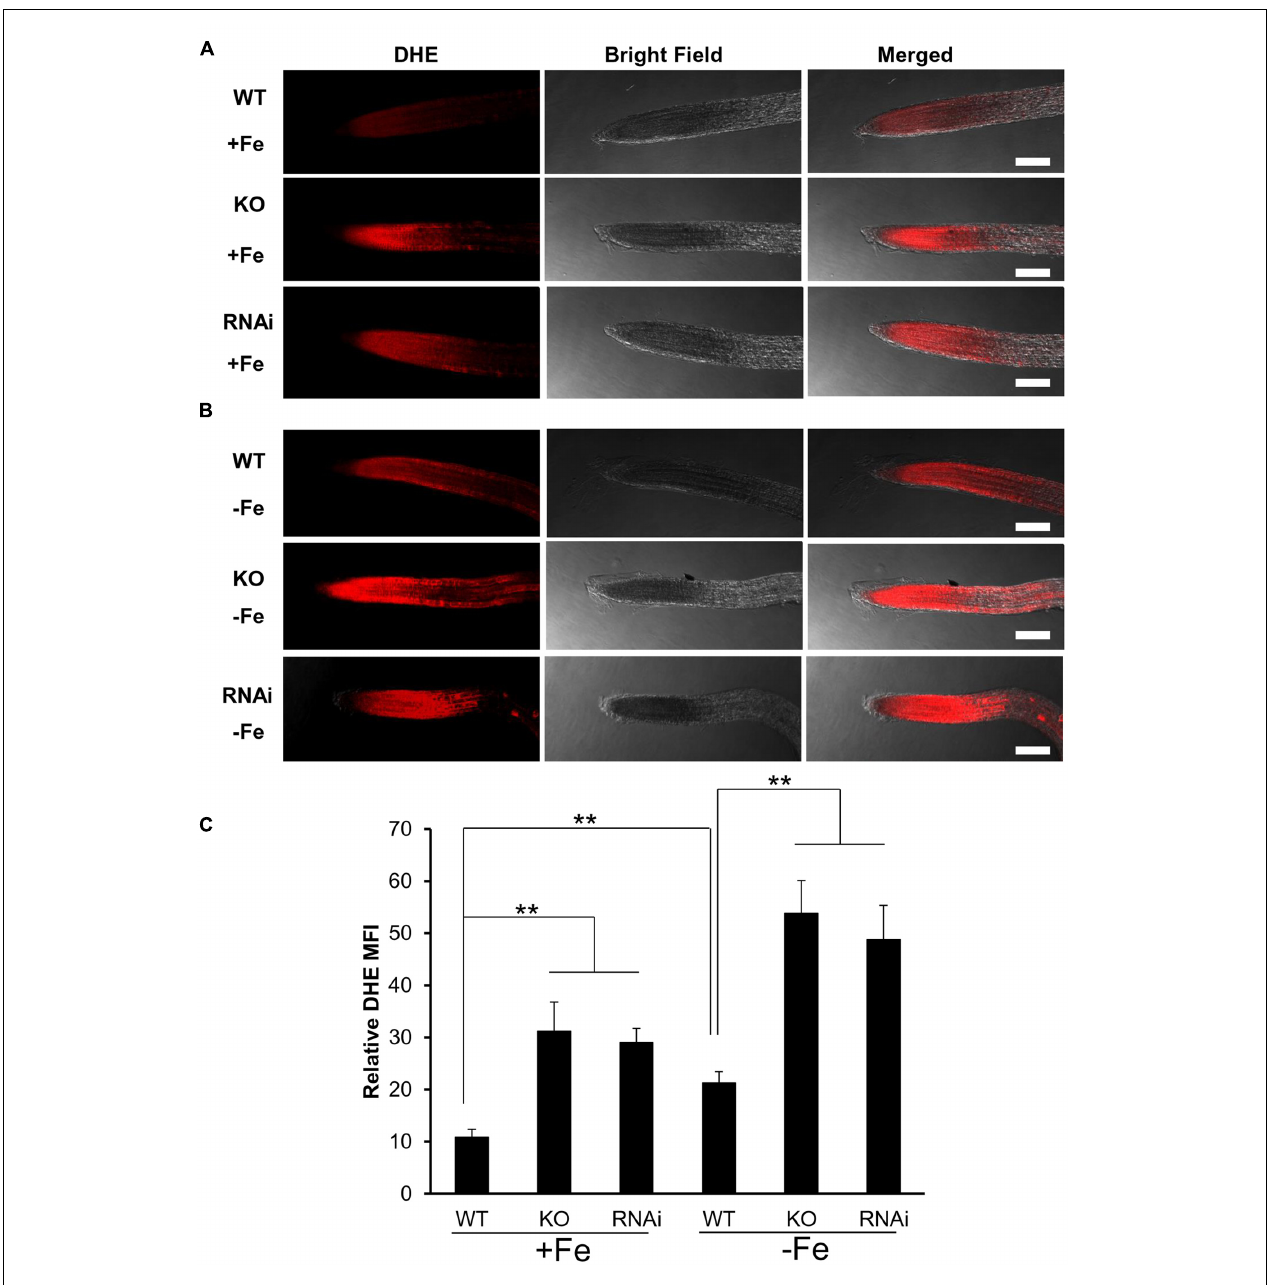
FIGURE 5 | atgrxs17 seedlings increase ROS production under iron deficiency stress. Wild type control, atgrxs17 KO, and AtGRXS17 RNAi seeds were germinated and vertically grown on 1 / 2 MS medium for 5 days, then transferred to and grown on iron sufficient or deficient medium for 3 days. Seedlings were stained with DHE to monitor ROS levels. Shown are representative images for iron sufficient (A) and deficient (B) treatments. Scale Bars = 50 µ m. (C) The intensity of ROS signals were captured by confocal microscope and analyzed with Image J. Student’s t -test, n = 6–10, ∗∗ p <